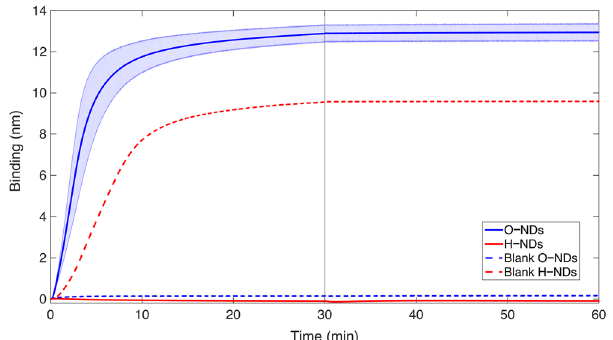
Figure 6. Bio–layer Interferometry data showing the difference in binding of H– and O–NDs to PL coated LN. The solid lines show the mean binding thickness of NDs onto the protein–coated sensor (O blue and H red). The pale blue and pale red block areas show the standard deviation from the mean. The dashed lines show the binding thickness of NDs (O blue and H red) of the blank sensors without any protein coating. The grey line at 30 minutes shows the transition of the biosensor from the ND coating solutions into DI